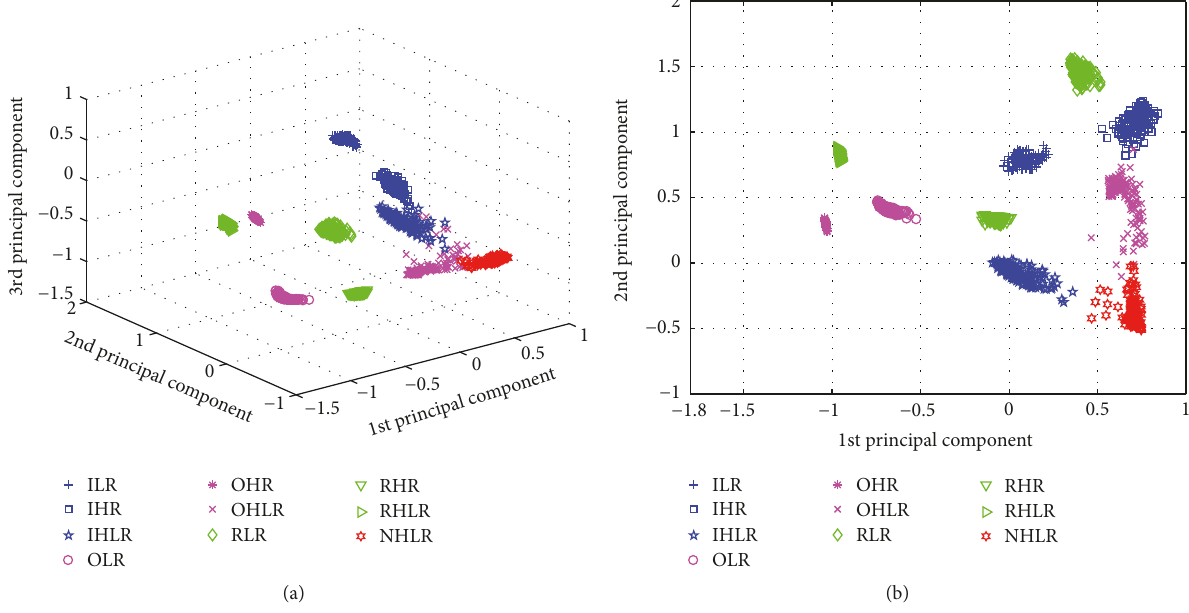
Figure 12: Feature visualization maps of the proposed method in Experiment 1. (a) The first three PCs; (b) the first two PCs.